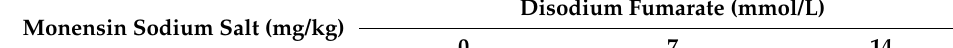
Table 1. Experiment design in